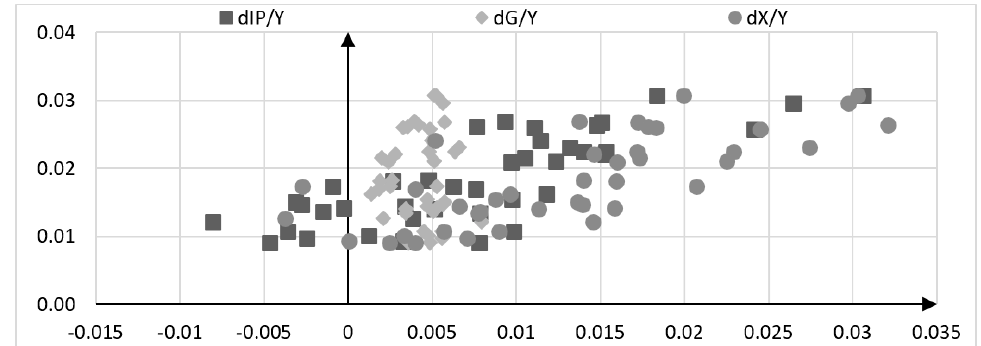
Figure 13. Correlation of changes in autonomous expenditure to changes in gross value added—France,